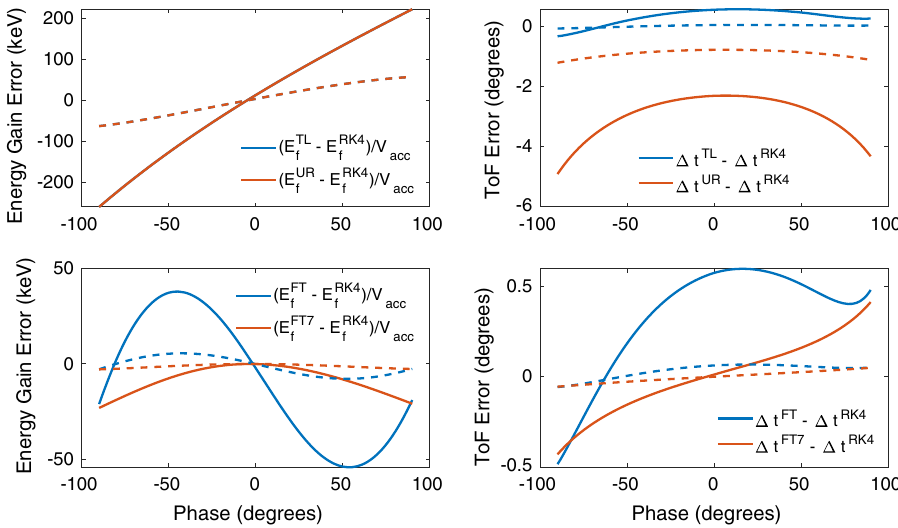
FIG. 3. Performance of TL, UR, FT, and FT7 cavity models with respect to a RK reference cavity at an incident beam energy of 6 MeV (solid lines) or 12 MeV (dashed lines) and maximum energy gain of 6 MeV. For cavities with length shorter than 7 cells (TL and FT), drift pipes have been added to either side to compensate for the length difference between the